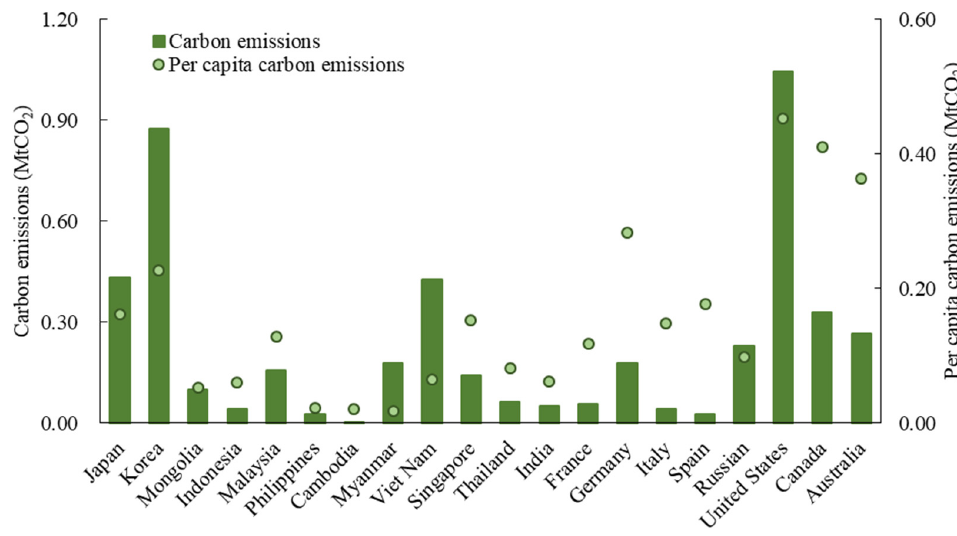
Figure 2. The sending system carbon emissions of China’s inbound tourism in 2015 (20 main countries are shown).